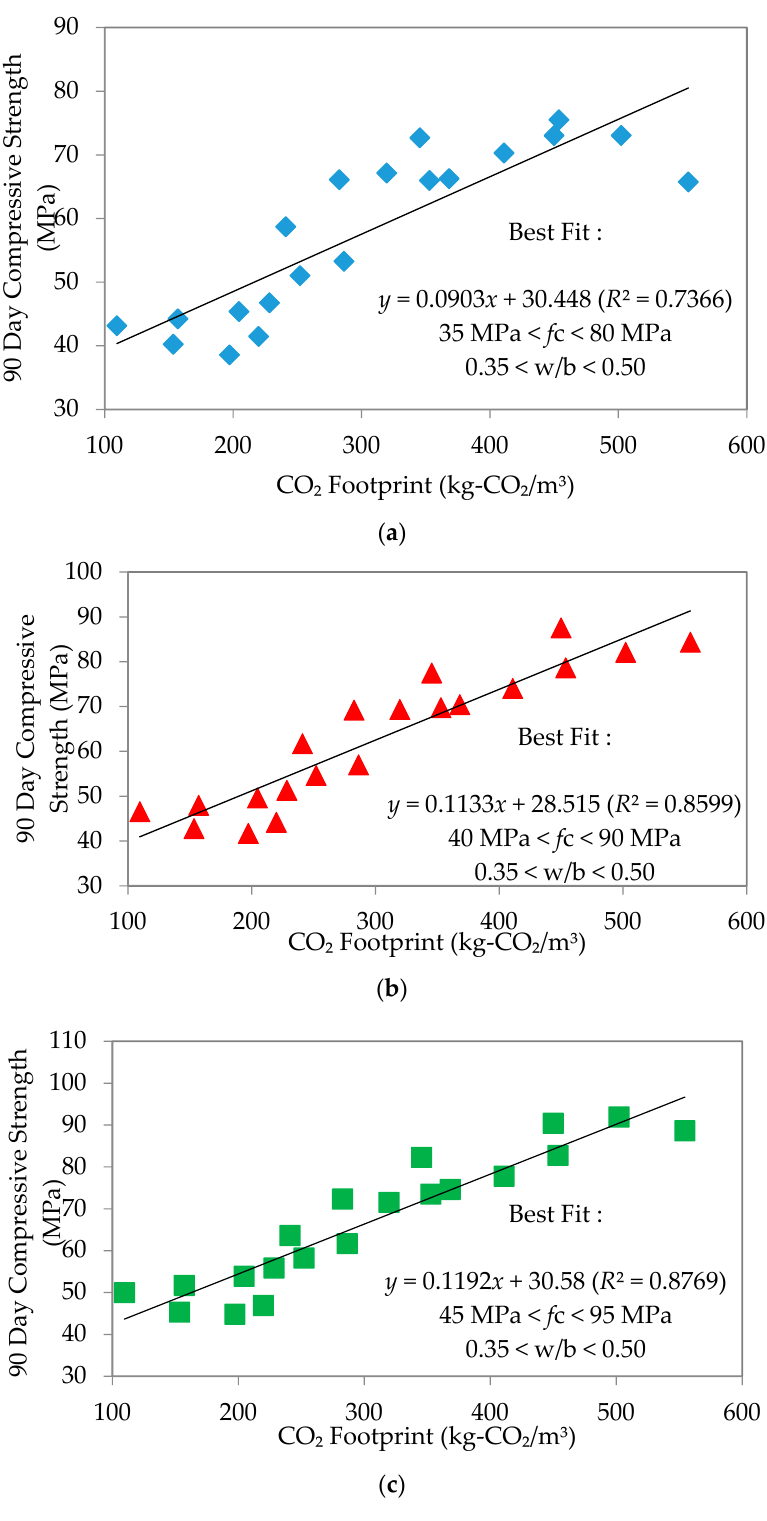
Figure 13. Compressive strength to CO 2 footprint on 90 days’ strength. ( a ) Normal flowability; ( b ) High flowability; ( c ) Self-compacting flowability